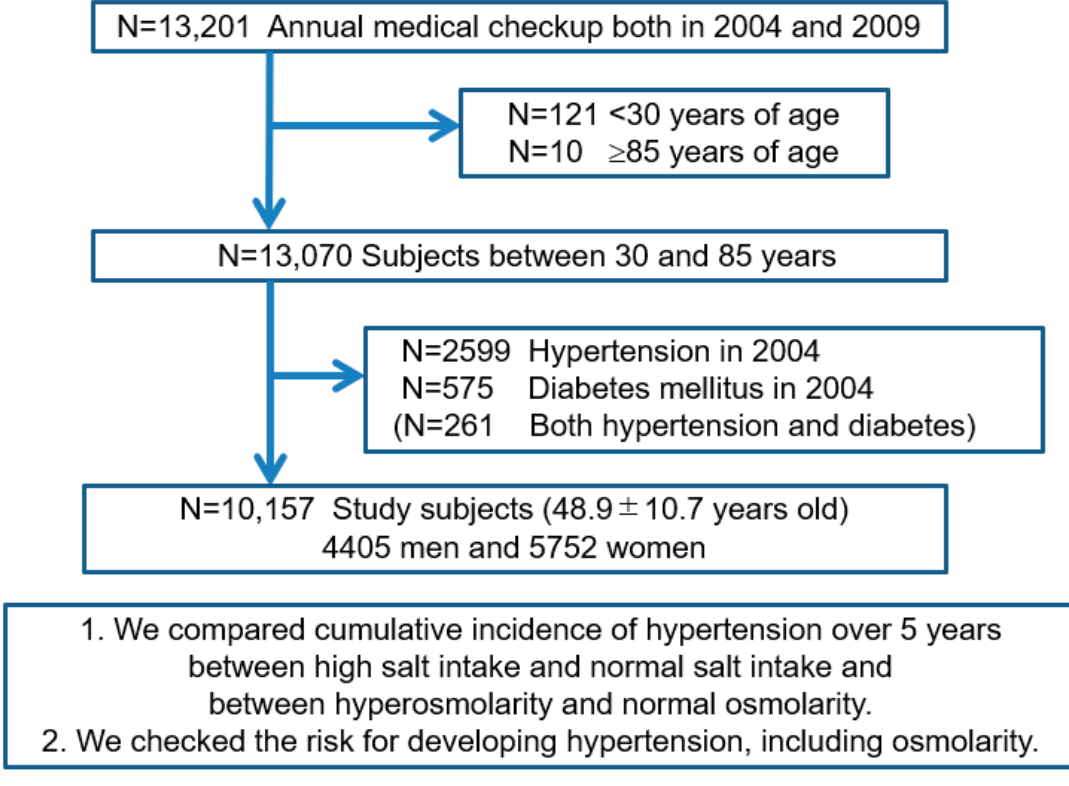
Figure 1. Flow diagram of study enrollment. Of 13,201 subjects who underwent annual medical examinations at the center in 2004 and again in 2009, we enrolled 10,157 subjects (4405 men) between 30 and 85 years old without hypertension and diabetes mellitus at the baseline (in